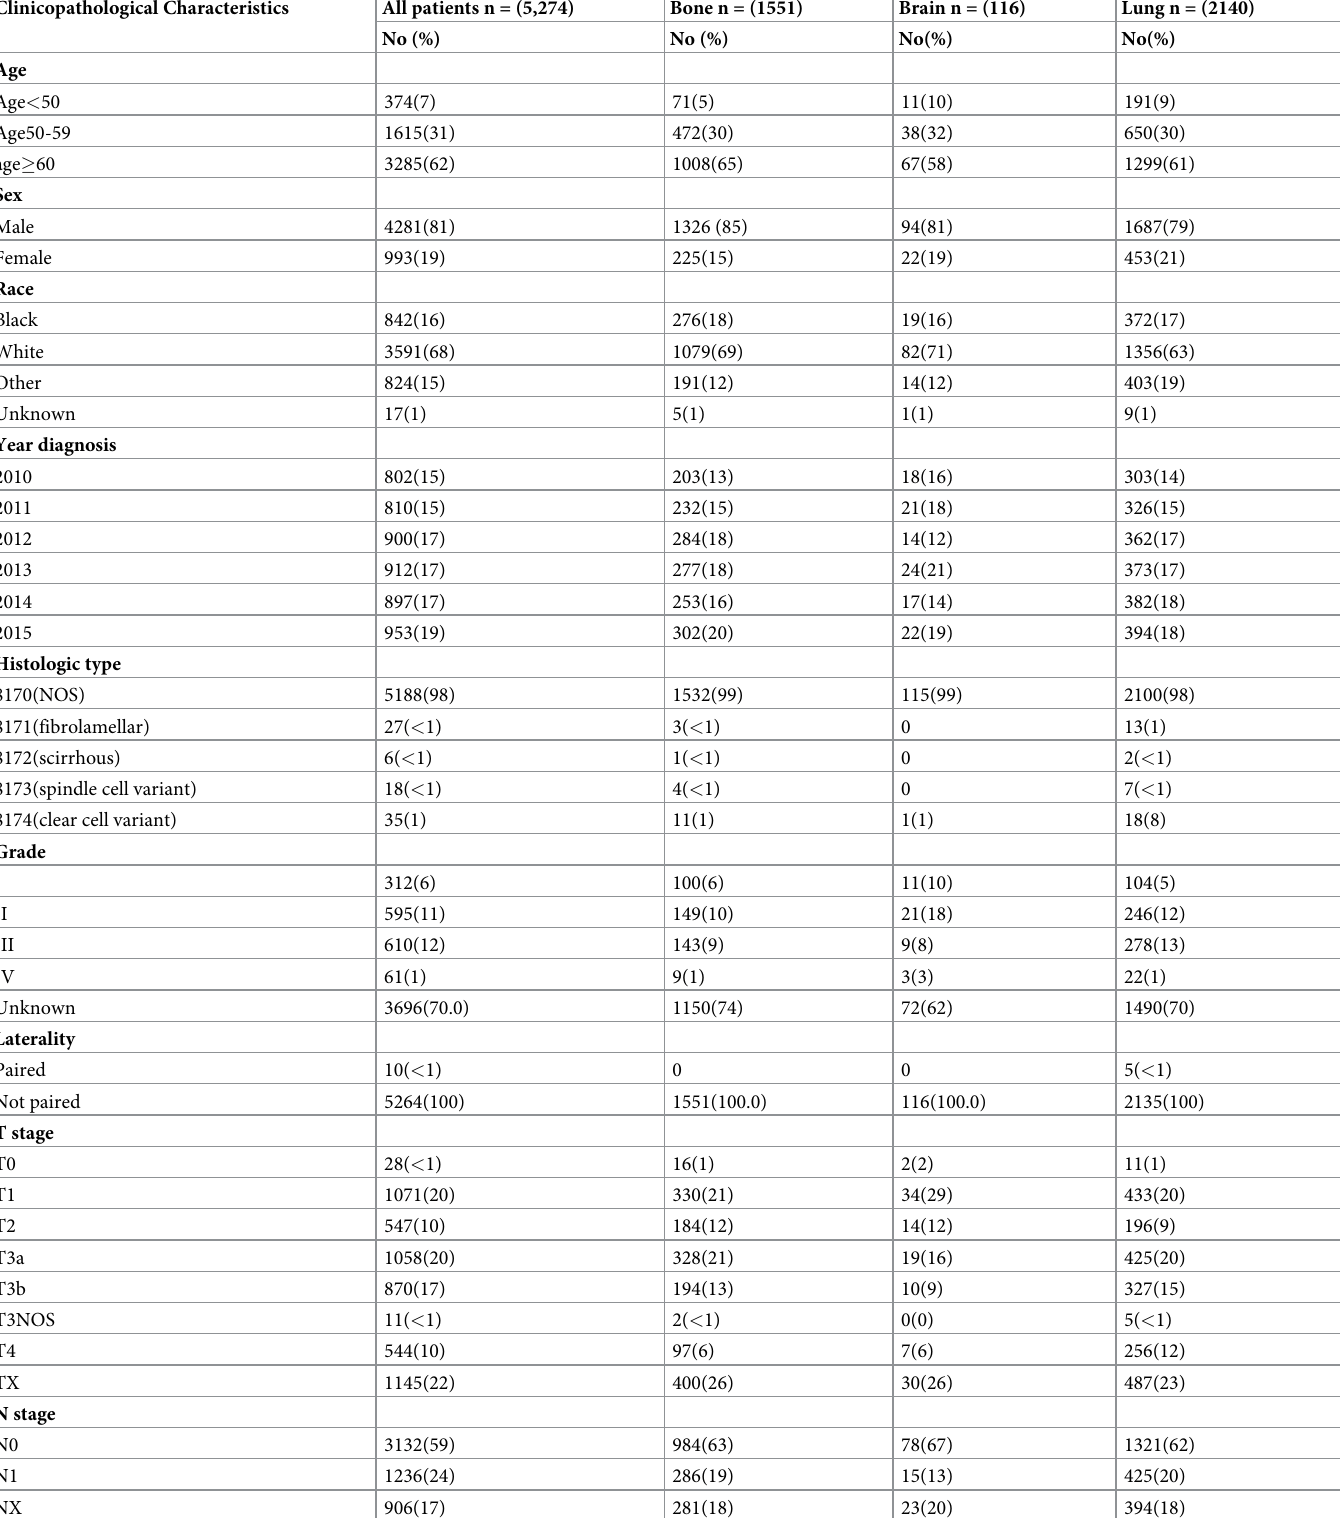
Table 1. Characteristics of